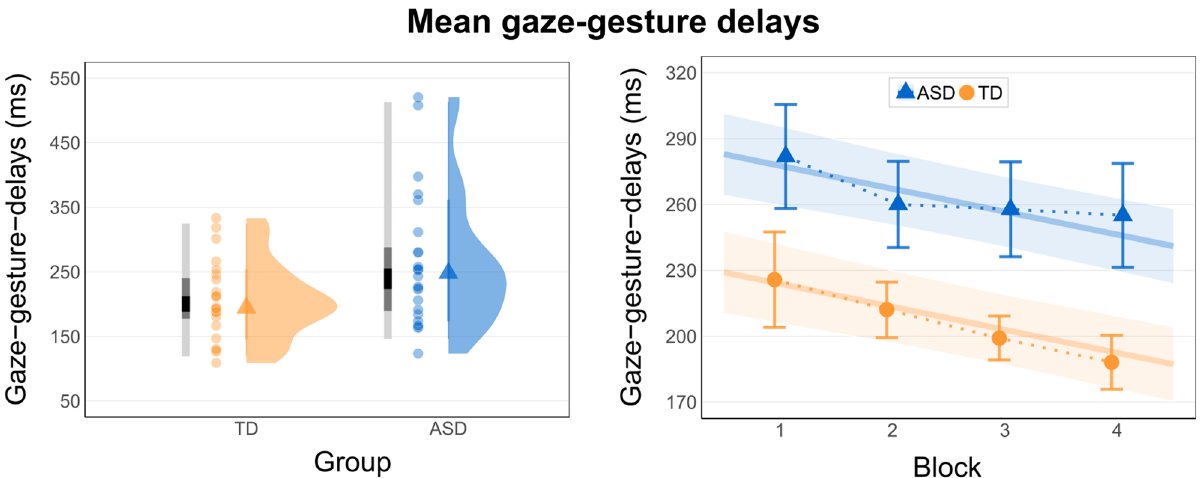
Figure 2. Gaze-gesture delays in both samples (left panel) and in both samples and experimental blocks (right panel). The delays represent the time in milliseconds from the onset of the communicative gaze shift to the onset of the pointing gesture . Left panel: Distribution of mean gaze-gesture delays aggregated for TD subjects in the comparison group in orange (left) and individuals with ASD in blue (right). Horizontally aligned density plots with medians (triangles), means per subject (point range), and the 25%, 50% and 95% colored confidence intervals (lightgrey = 95%; darkgrey = 50%; black = 25%). Right panel: Mean gaze-gesture delays of the ASD group in blue (triangles) and comparison group in orange (circles), separately for the four experimental blocks with standard errors of the means as error bars. Estimated linear regression lines for ASD group (blue) and comparison group (orange) with confidence bands displaying the standard error of estimates.